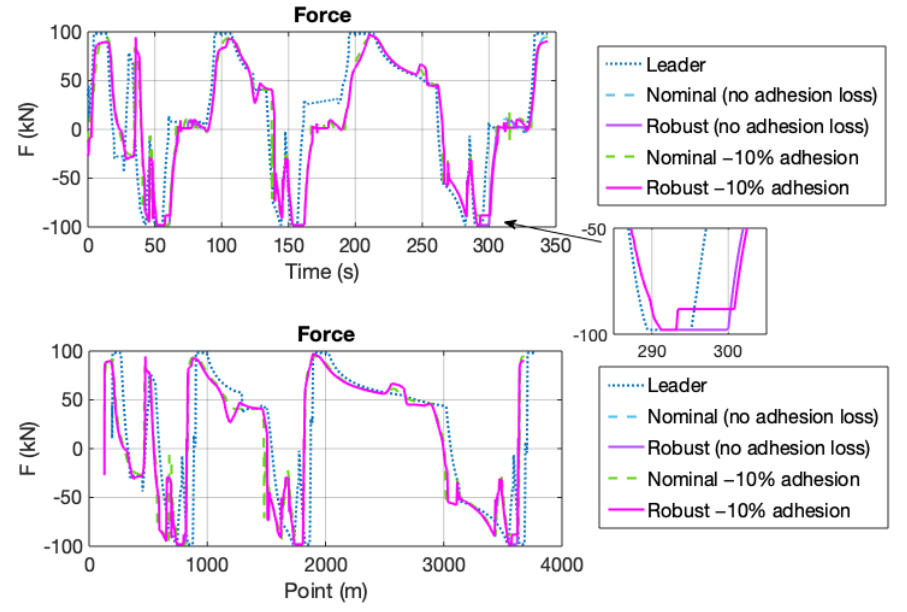
Figure 6. Results of simulation 1: 10% adhesion loss. Force vs. time.